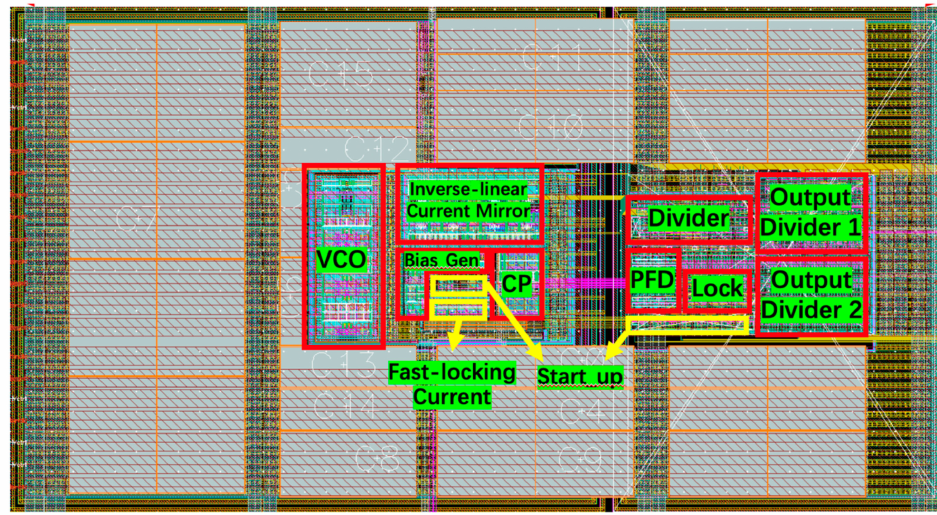
Figure 6. Layout of the fast-locking